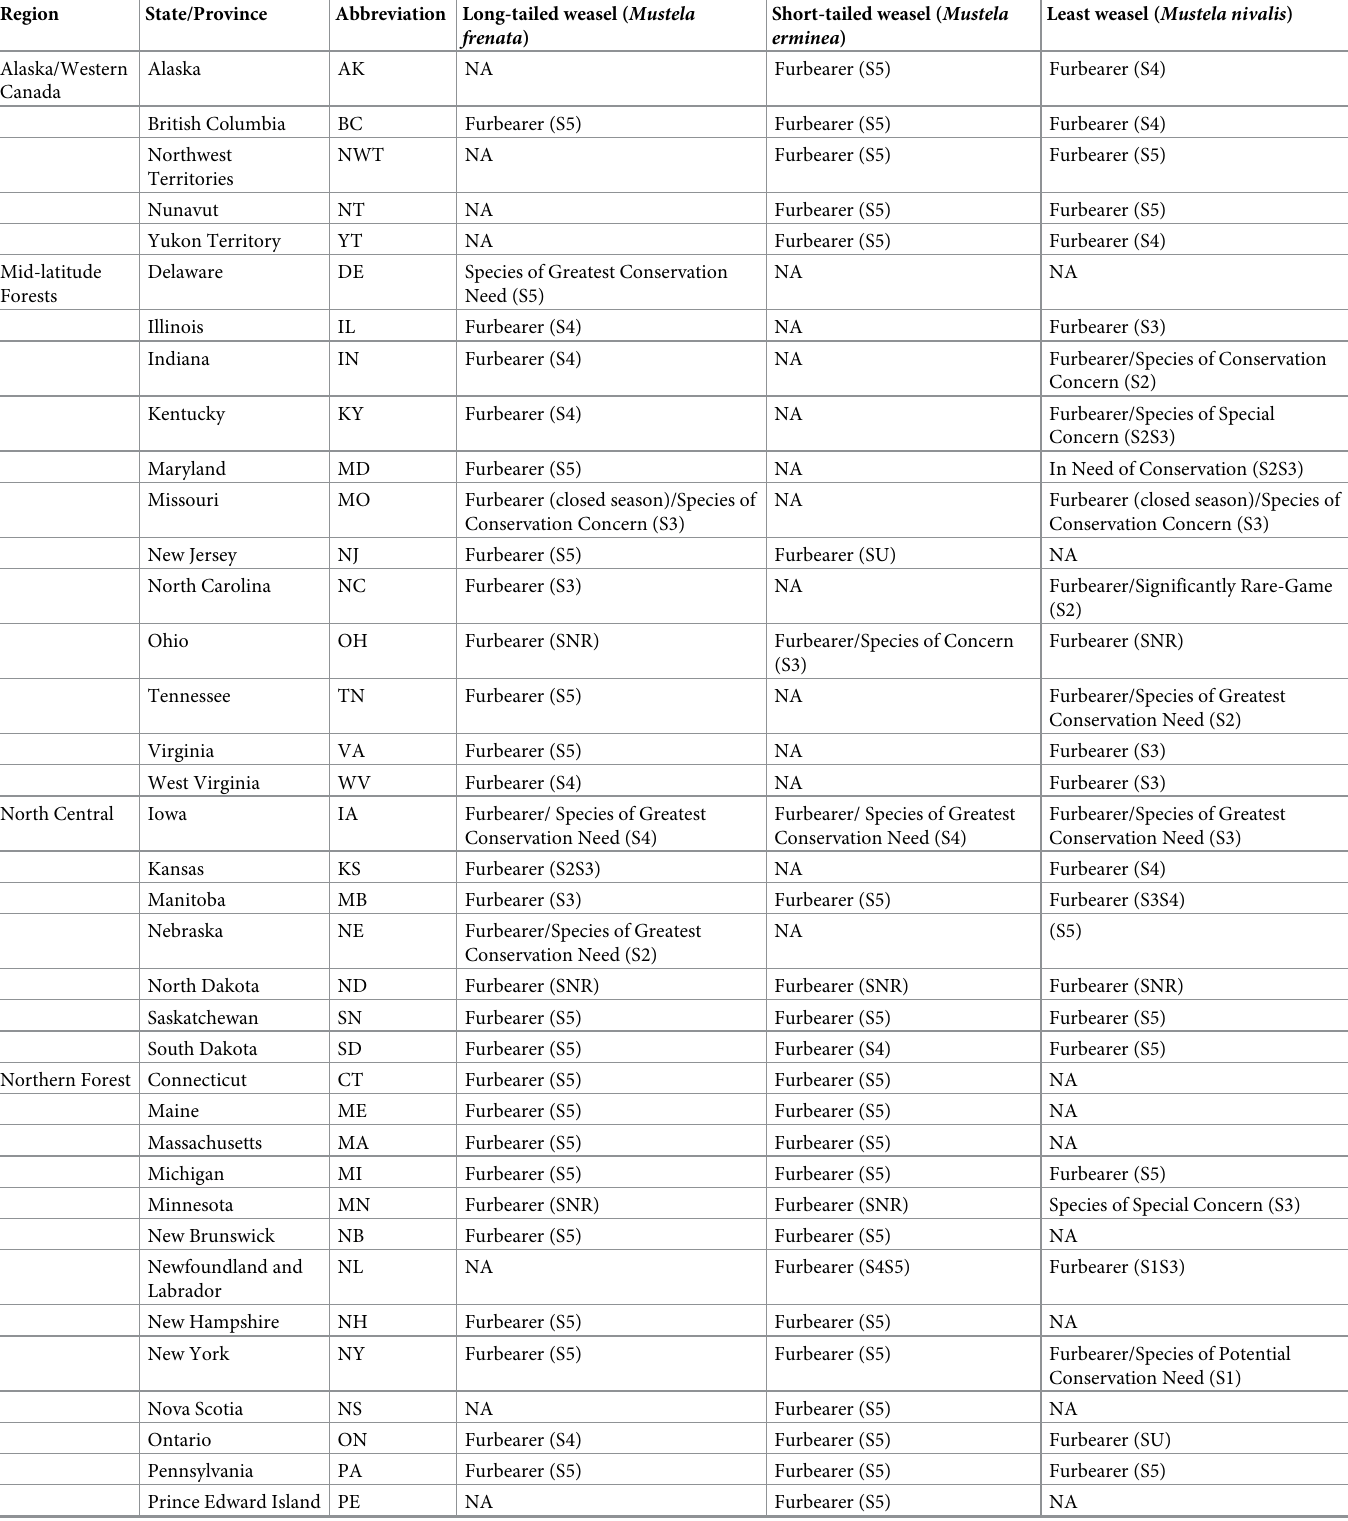
Table 1. NatureServe state conservation status rank of weasels ( Mustela sp.) in the United States and Canada (data accessed November 24, 2020).